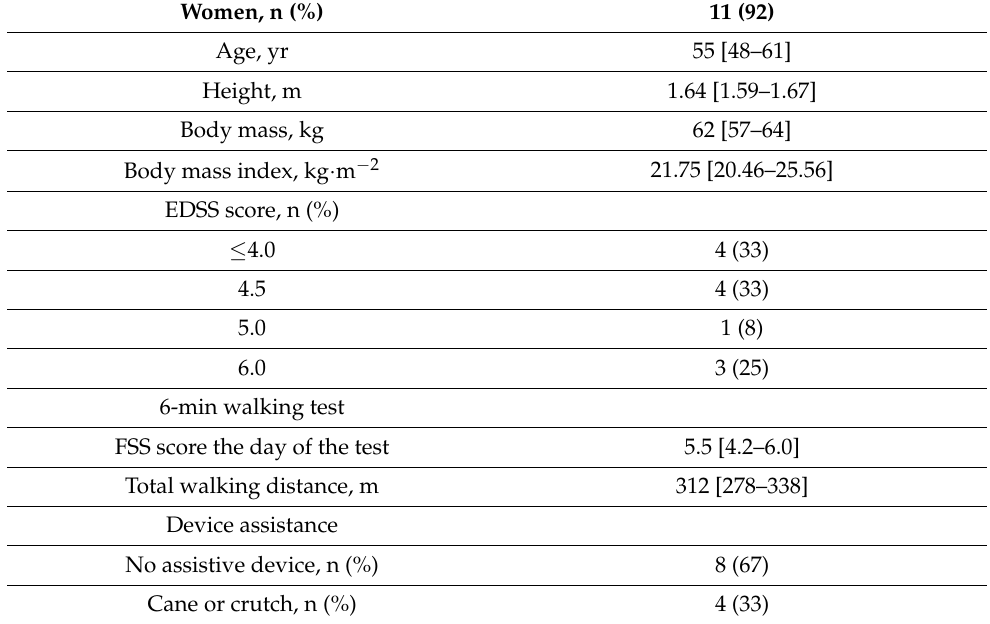
Table 1. Participants Characteristics ( N =